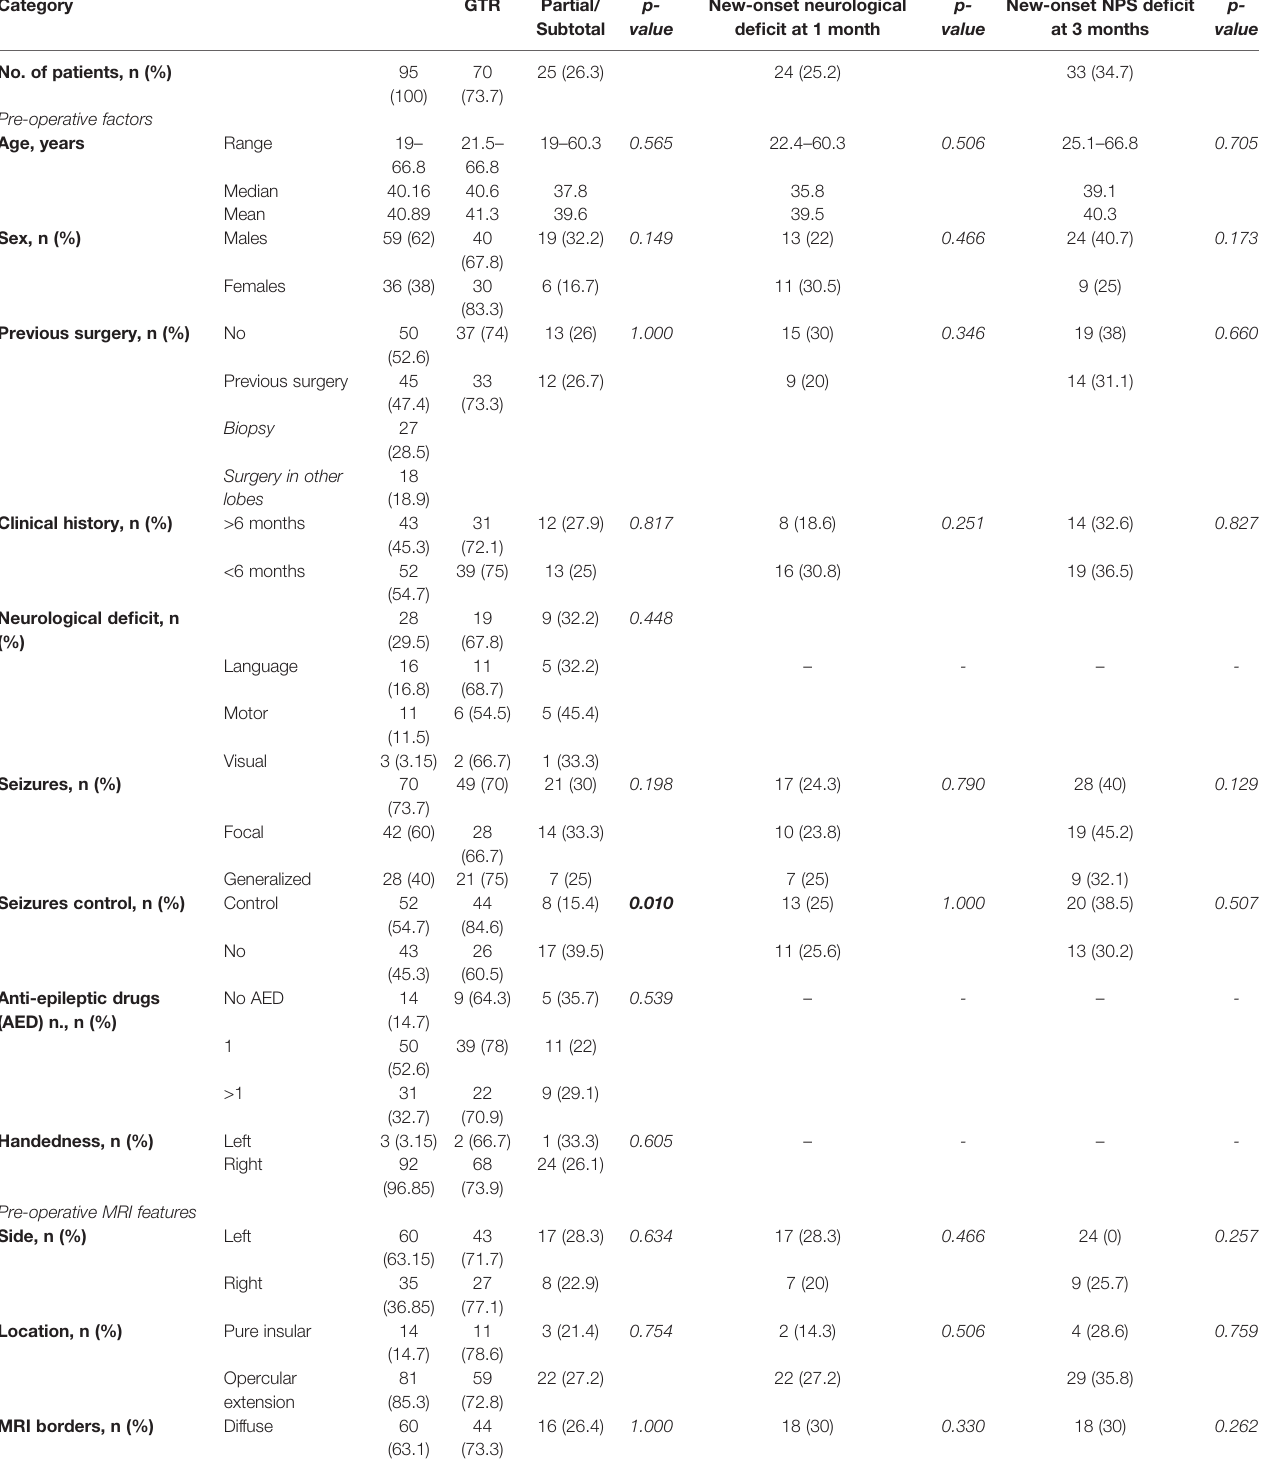
TABLE 1 | Clinical, imaging, pathological, and surgical